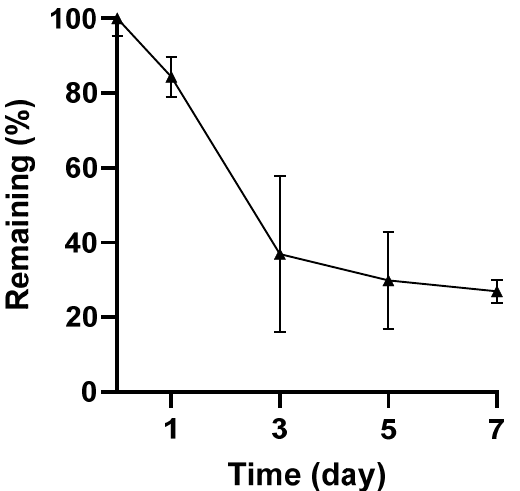
Figure 5. The remaining (%) of acDrug in T-DM1 was calculated by relative ratio to the concentration of desulfurated DM1 at day 0, which was the initial incubation time. The results show that desulfurated DM1 as acDrug decreased dramatically to 36.97% at day 3, and then slowly decreased until day 7 in rat plasma.